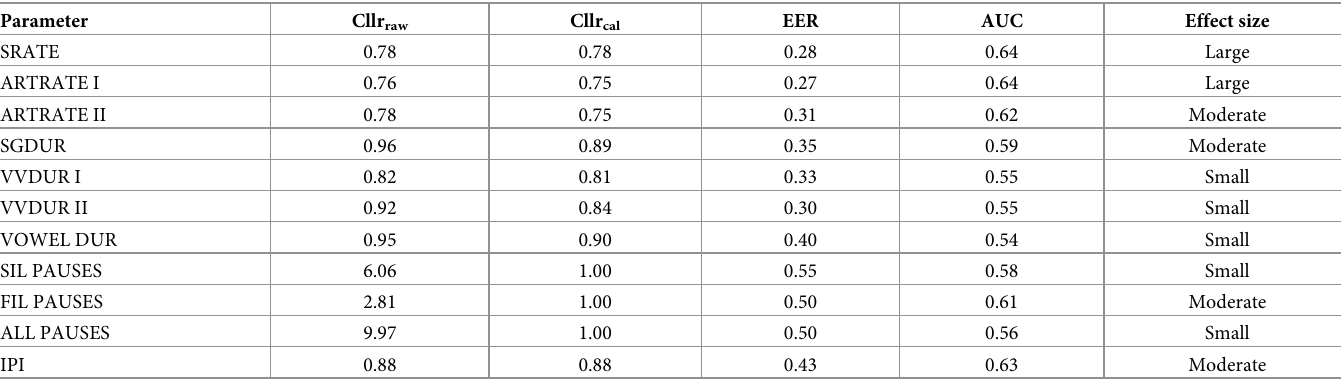
Table 4. Raw and calibrated likelihood-cost ratios (Cllr), equal error rates (EER), multi-class AUC values for cross-pair comparisons, and effect sizes ( η 2 ). Parameter